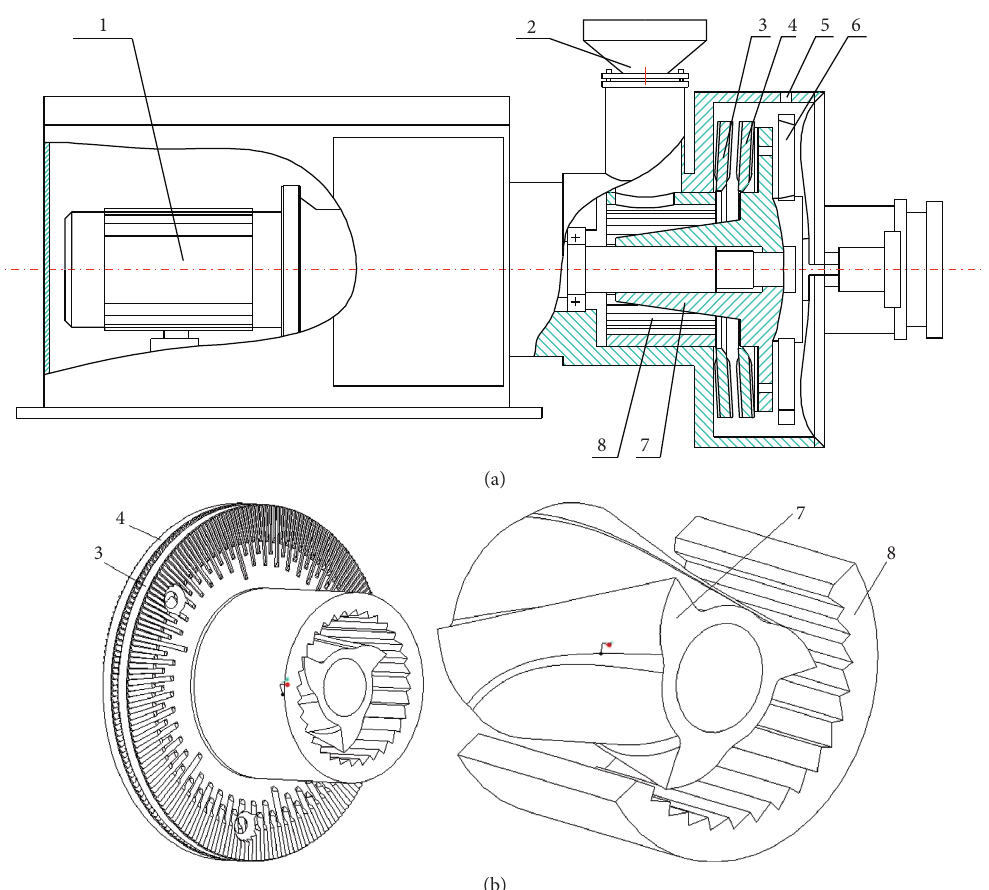
Figure 2: Model of experimental machine.1: stepless speed regulating motor; 2: feed inlet; 3: static grinding disc; 4: moving grinding disc; 5: temperature sensor; 6: impeller-type stirring cutter; 7: shearing arbor; 8: fixed annular cutter. (a) Schematic diagram of thermosetting plastic recovery experimental machine. (b) Three-dimensional model of the crushing cavity.